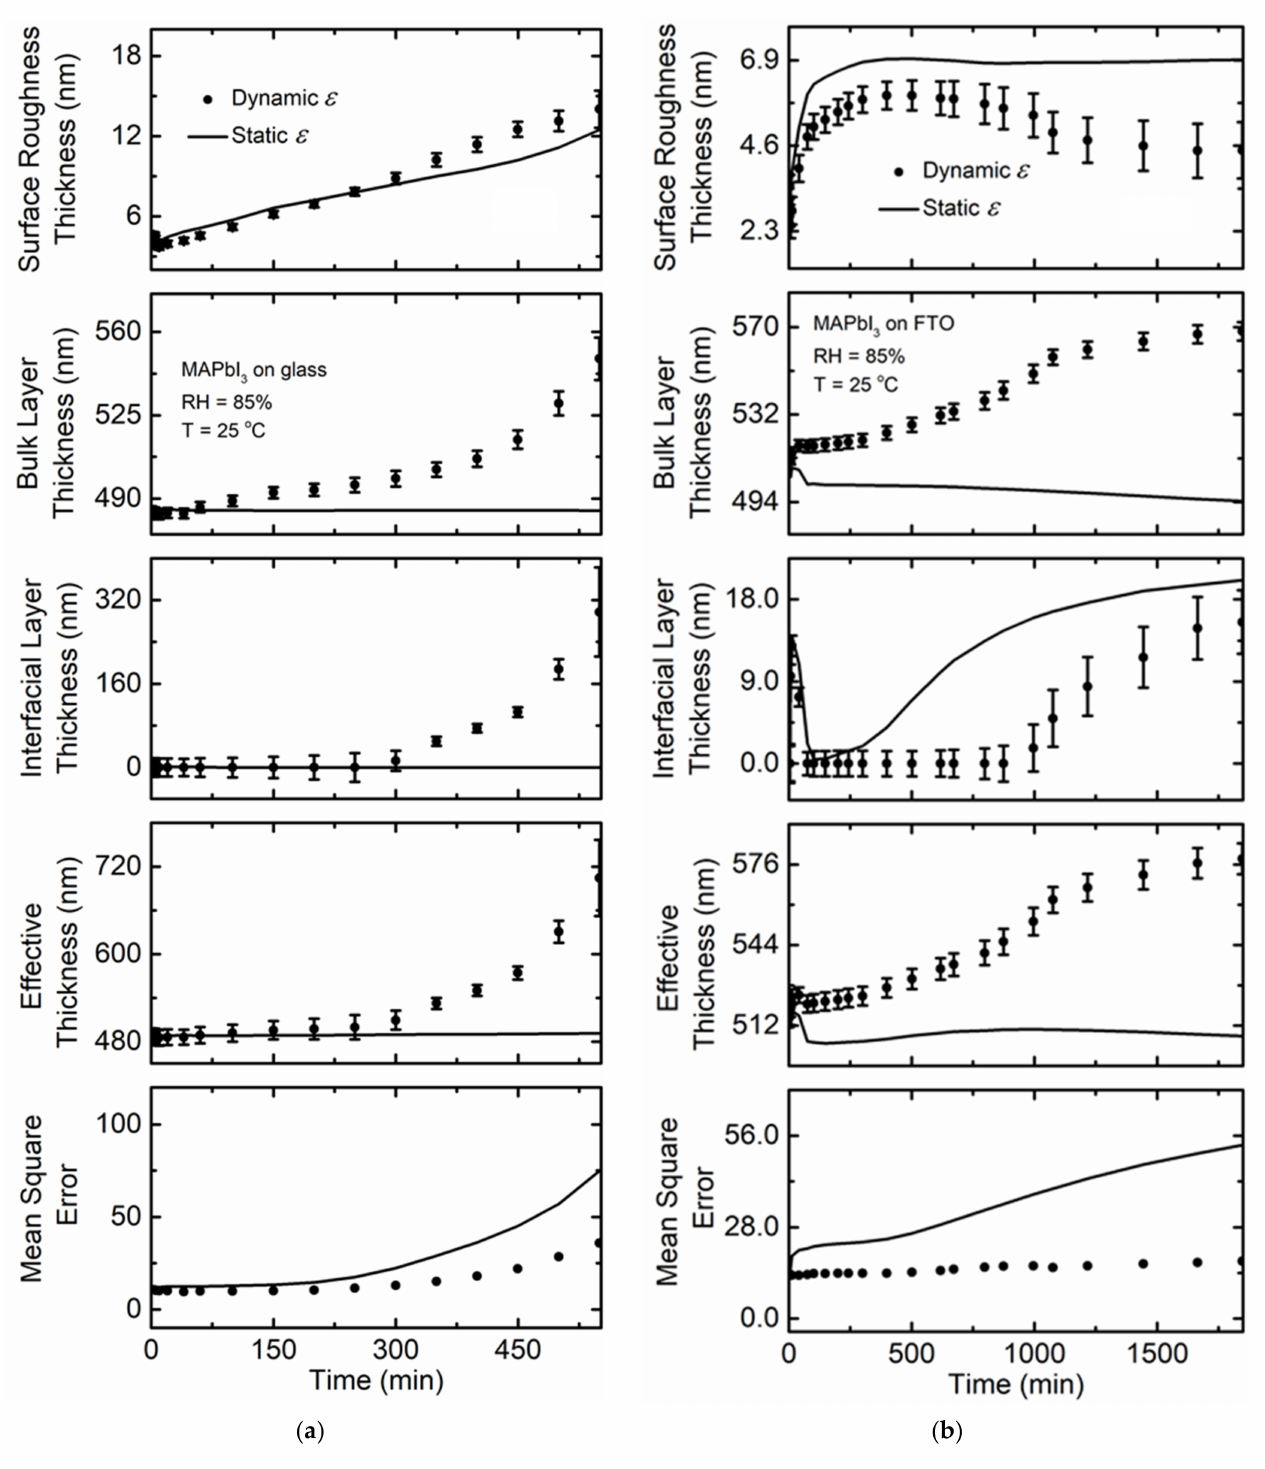
Figure 3. Surface roughness thickness, bulk layer thickness, interfacial layer thickness, effective perovskite thickness, and the quality of fit between the model and experimental ellipsometric spectra in the term of mean square error at selected time points as functions of time for thin film MAPbI 3 on ( a ) soda lime glass and ( b ) FTO coated glass when exposed to 85% RH at 25 ◦ C. Values obtained assuming the initial spectra in ε (time = 0 min; static) prior to exposure are represented by a solid line, and spectra in ε fit at each time point (dynamic) are represented by solid circles. RH is introduced at 5 and 4 min for ( a ) and ( b ),